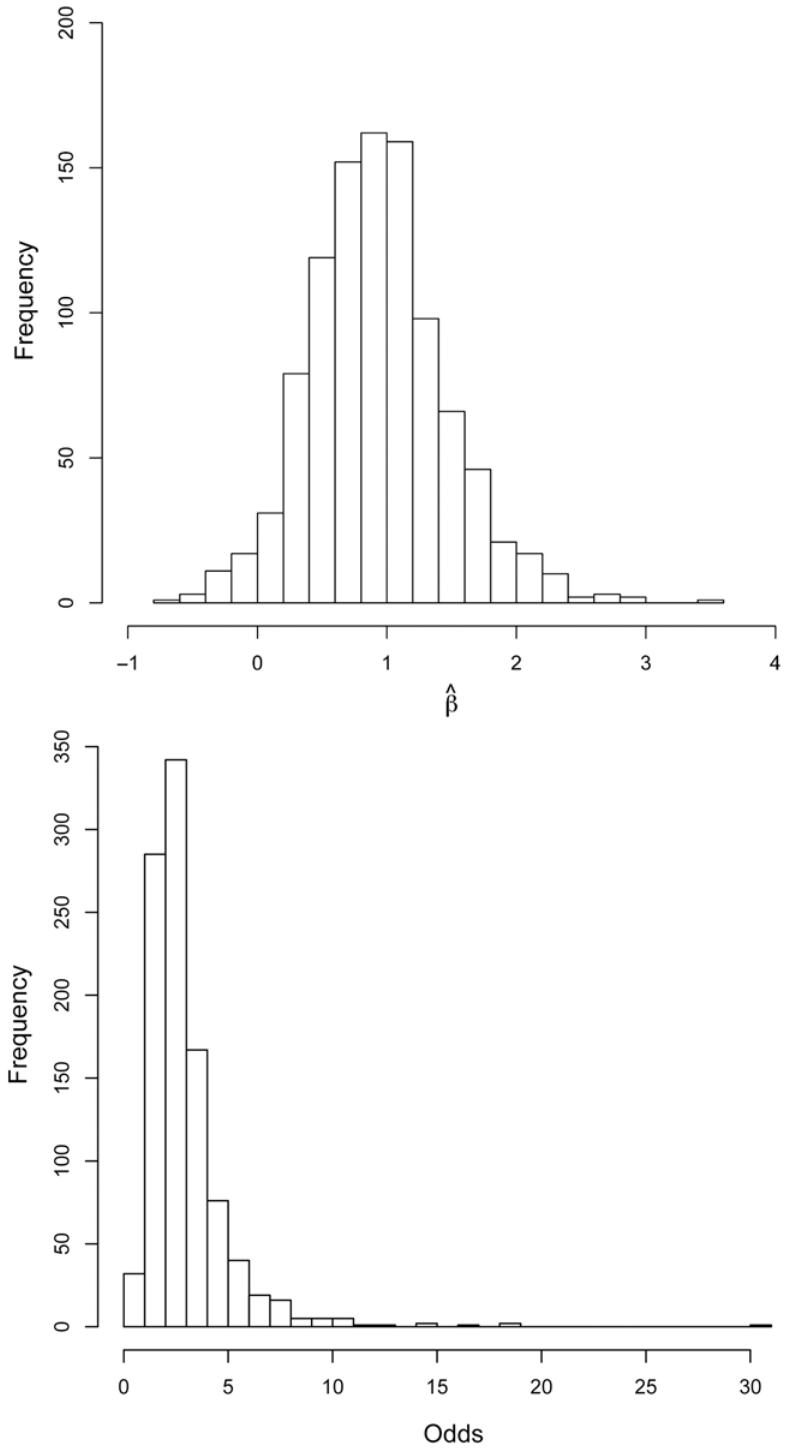
Fig 6. Distributions of simulated regression coefficients (top) and effect sizes (bottom) from the regression of early childhood mortality on C/P resulting from 1000 random perturbations to the age- and sex-specific weights used to compute C and